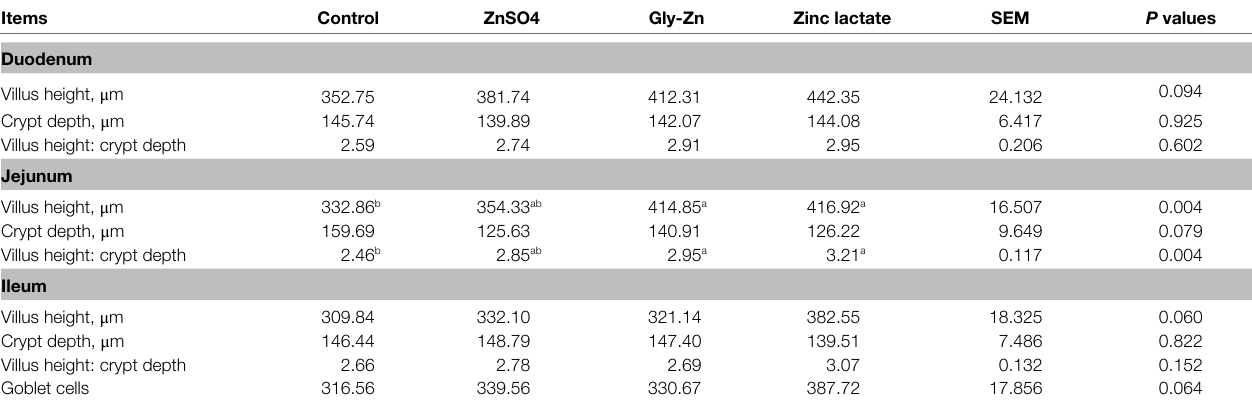
TABLE 6 | Effect of dietary zinc sources on the intestinal morphology and number of goblet cells in weaned piglets.